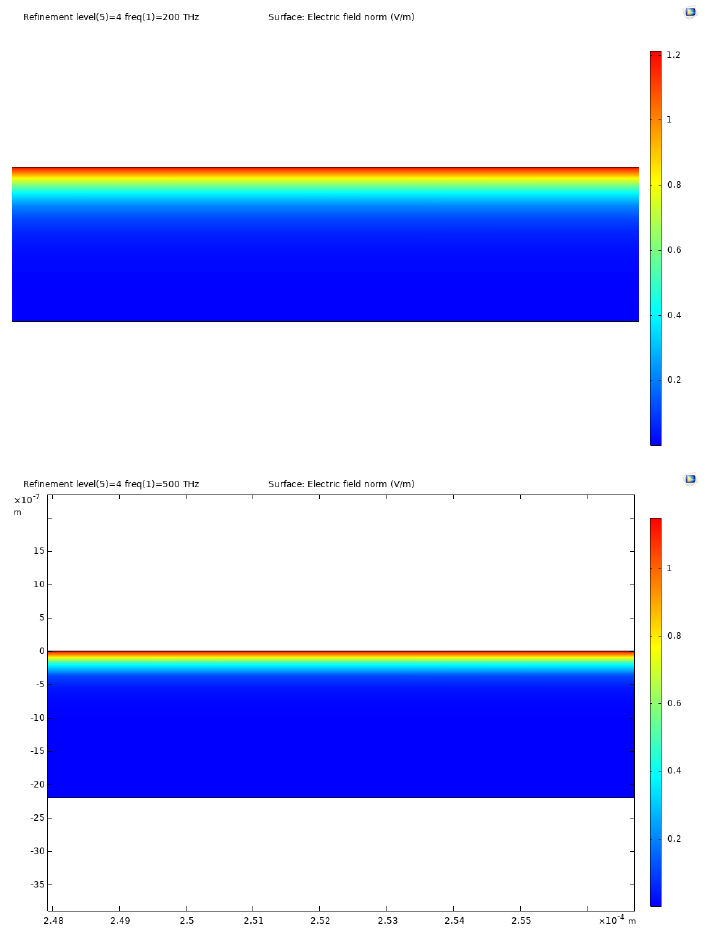
Figure A5. Electric field norm of Ga 0.66 In 0.34 As at 200 THz and 500